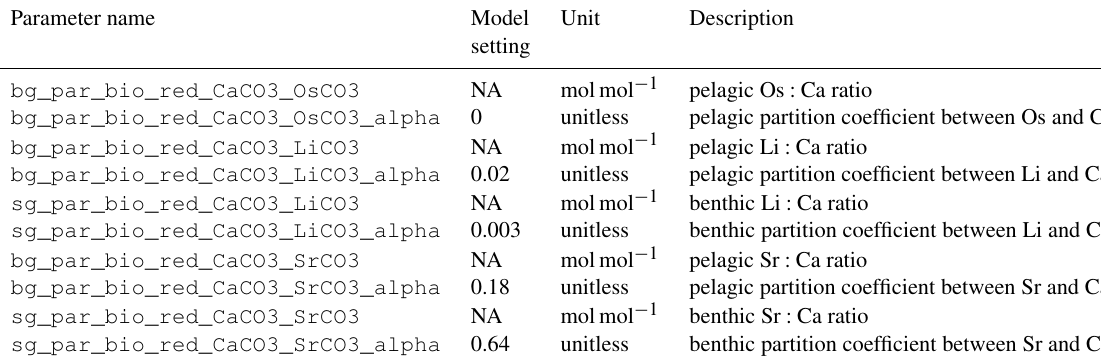
Table E3. Model parameters setting the Os, Li and Sr contents of calcite shells.